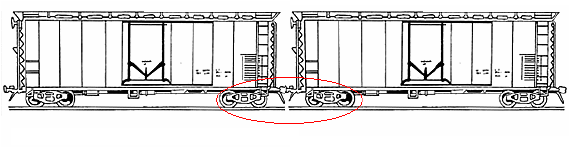
Figure 7: Two cars with 8 wheels for each car [6].